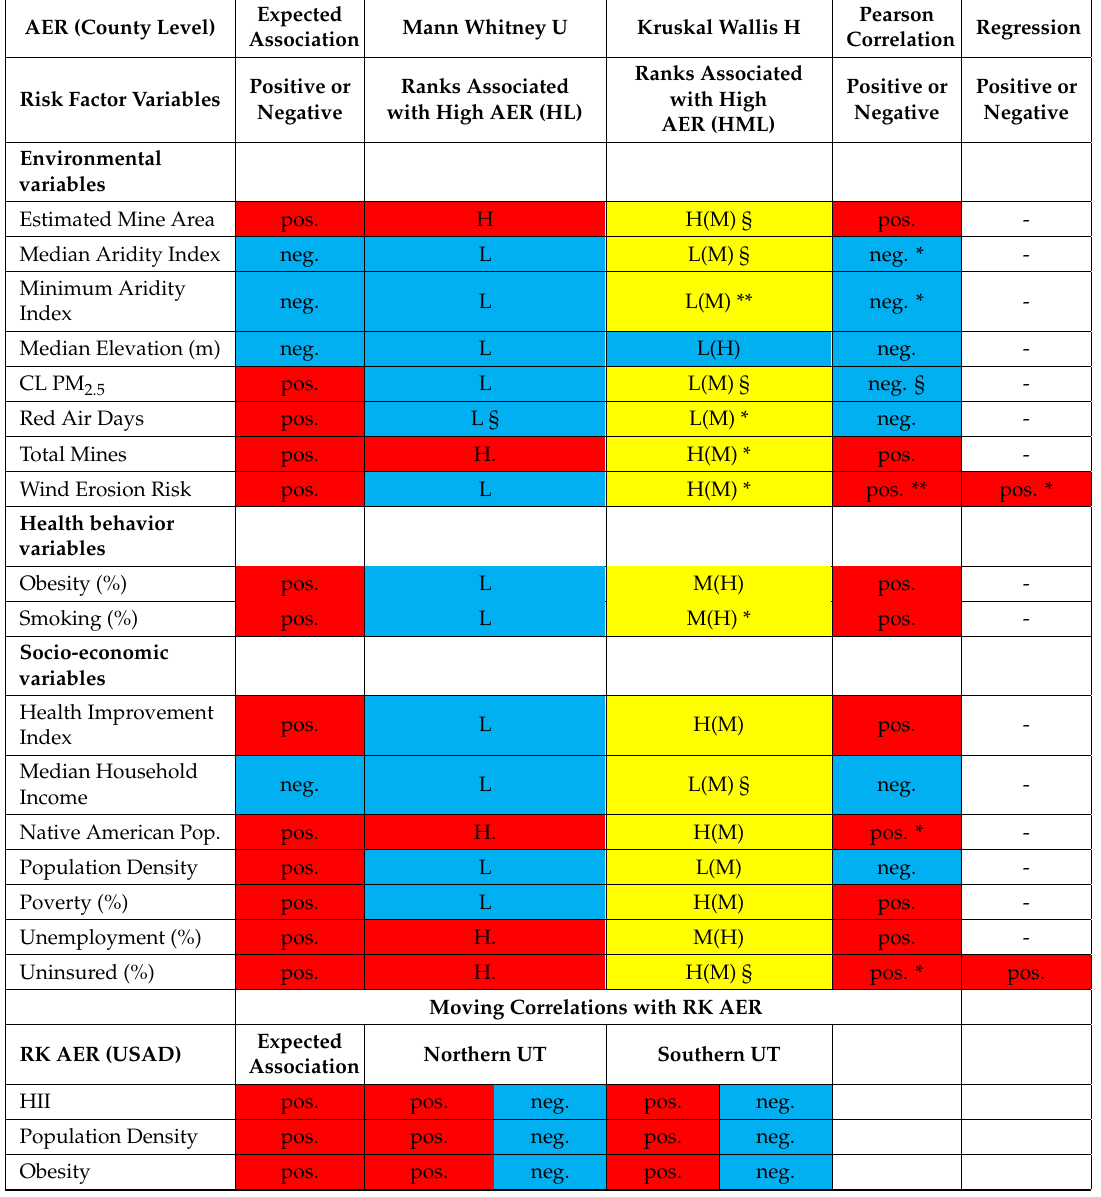
Table 8. Summary of all associations between risk factors and AER found in statistical analysis (red indicates positive association, blue indicates negative association, yellow indicates changing